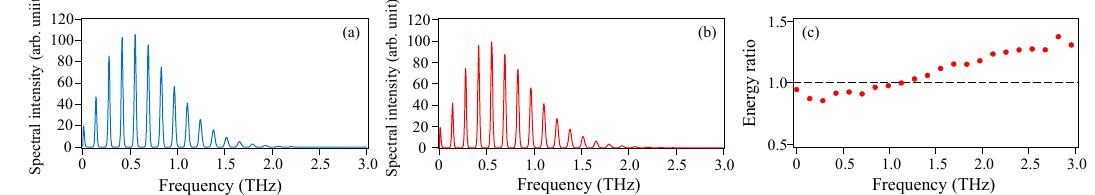
Figure 12. Spectral traces of the THz-TDS outputs averaged over 2000 single-shot spectra, when Langevin noise is ( a ) excluded and ( b ) included; ( c ) ratio of the energy at each line spectrum in ( b ) to that in ( a ).